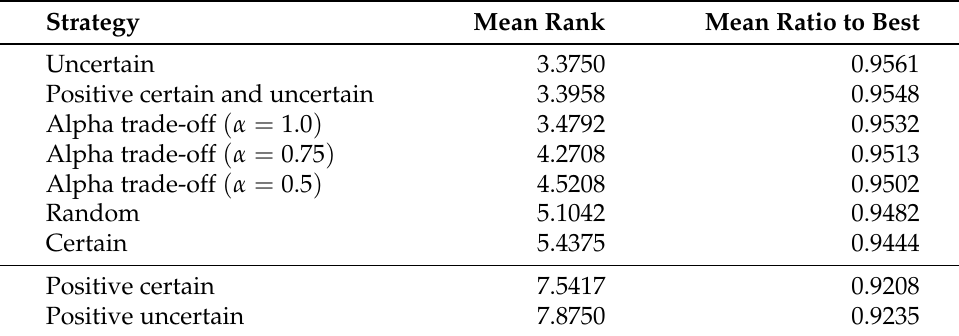
Table 6. AL strategies sorted according to mean rank of ROC